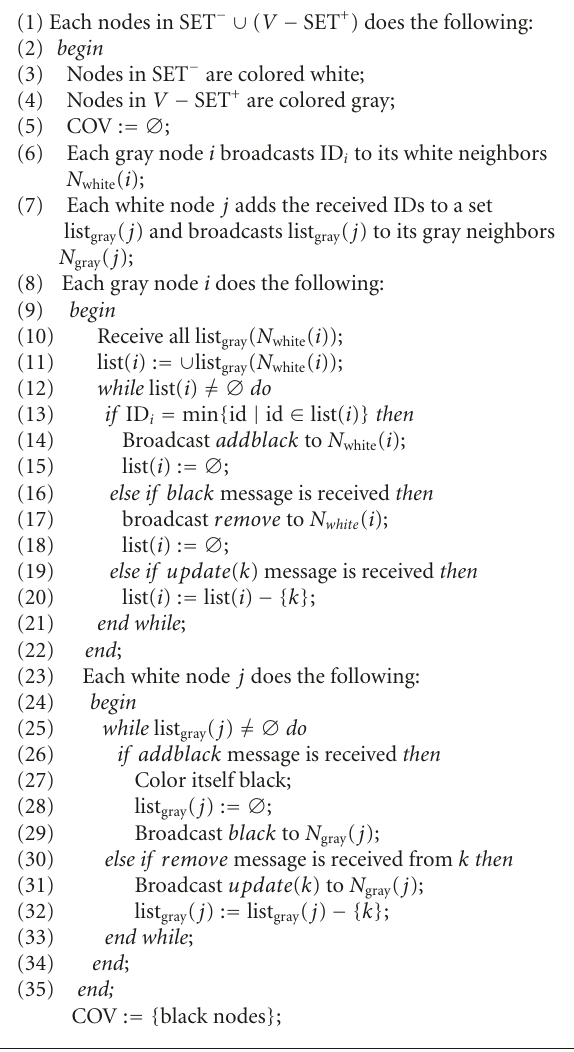
Algorithm 5: COV finding